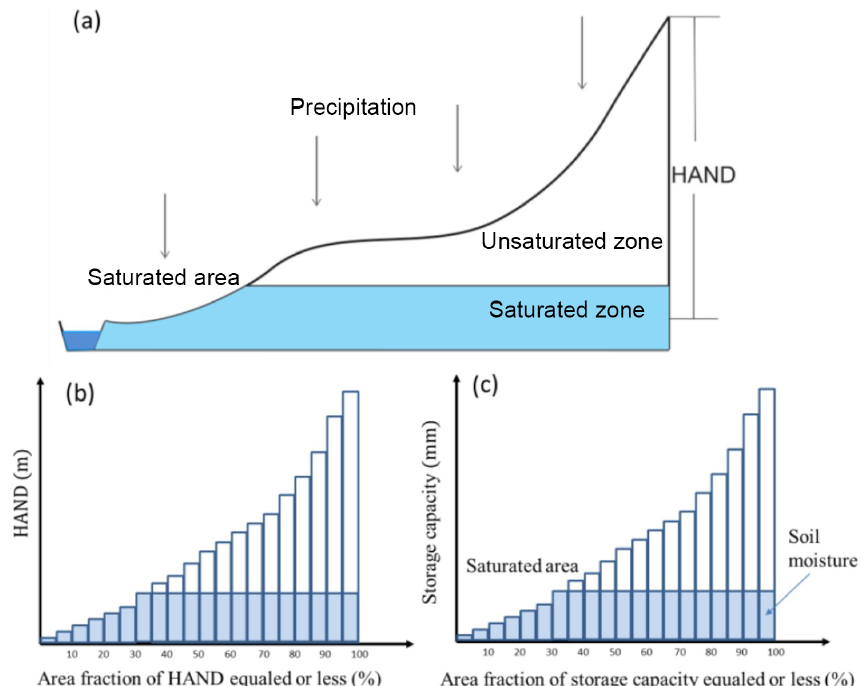
Figure 2. The perceptual model of the HAND-based Storage Capacity curve (HSC) model. Panel (a) shows the representative hillslope profile in nature, and the saturated area, unsaturated zone and saturated zone; panel (b) shows the relationship between HAND bands and their corresponded area fraction; panel (c) shows the relationship between storage capacity-area fraction-soil moisture-saturated area, based on the assumption that storage capacity linearly increases with HAND values.